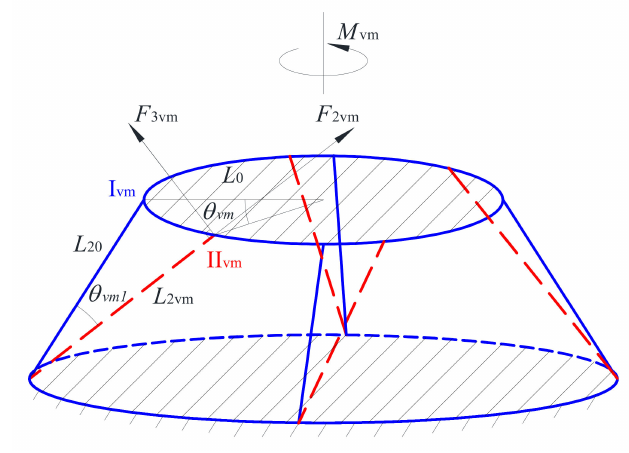
Figure 7. Schematic diagram of vertical rotation.